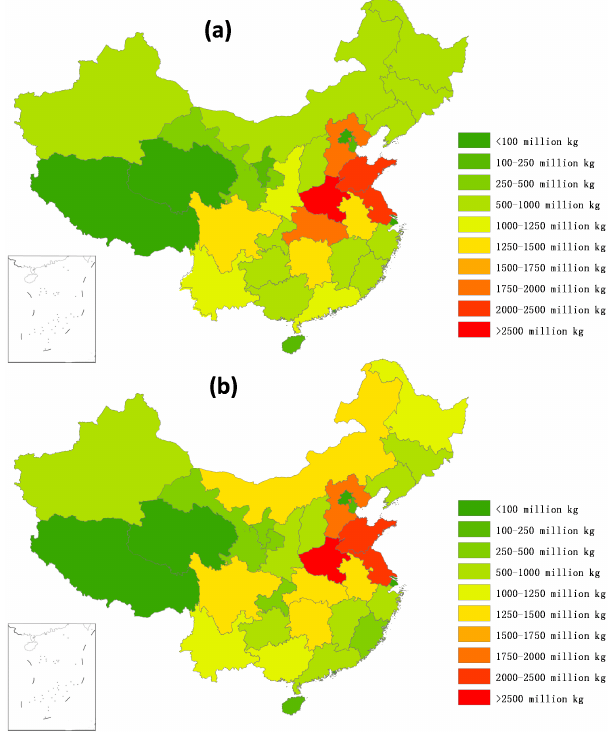
Figure 4. Comparison of annual N fertilizer use at province level between existing statistical data (a) and EPIC output (b) . The small insert represents the South China Sea and its islands.